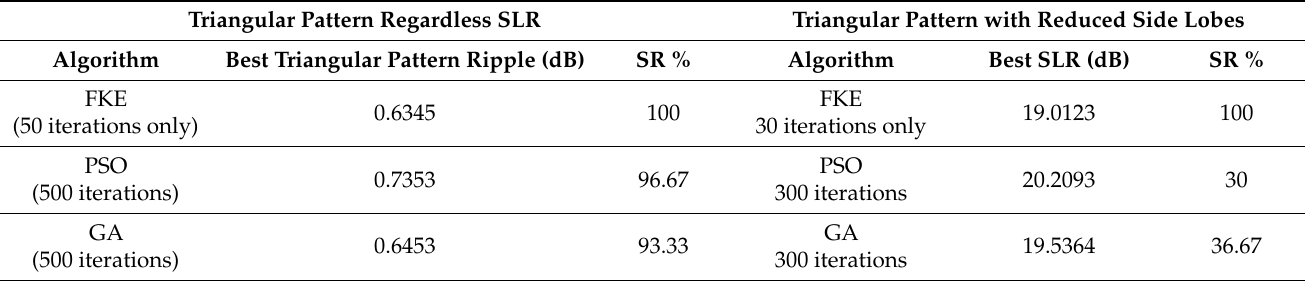
Table 7. The success rate (SR) of the proposed FKE algorithm, PSO, and GA for the triangular pattern. (No. of runs = 30). Triangular Pattern Regardless SLR Triangular Pattern with Reduced Side Lobes Algorithm